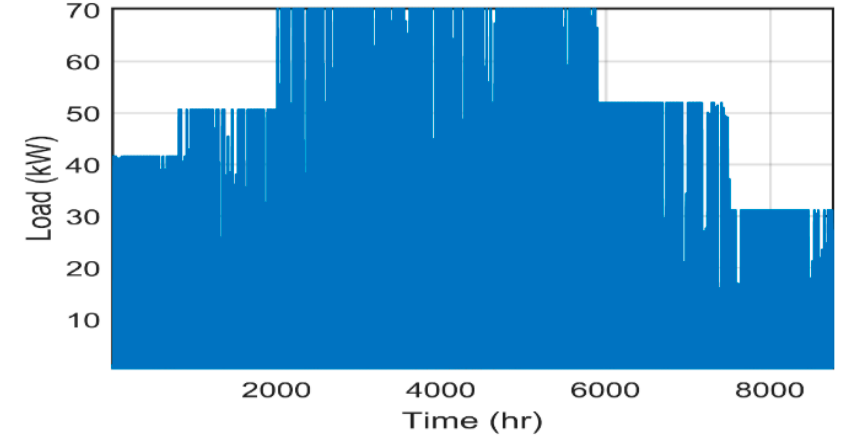
Figure 5. Annual load curve over a time interval of one hour with a peak demand of 70 kW.